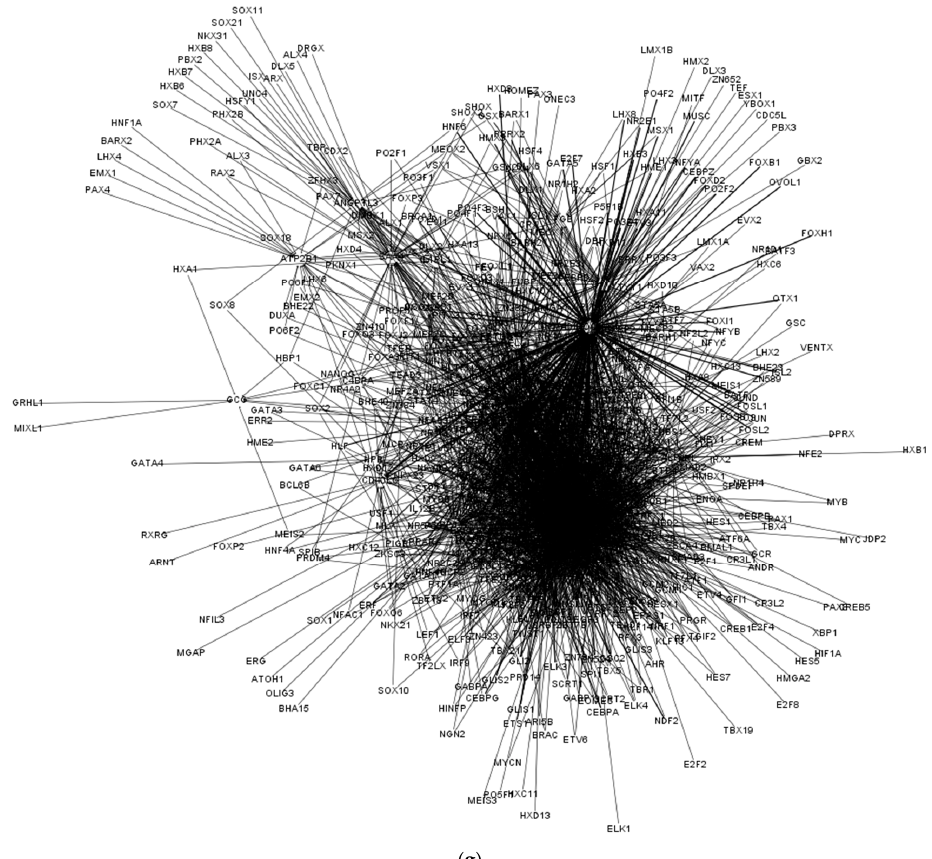
Figure 2. Receptor regulatory subnetworks of normal immune cells. In the network, nodes represent genes and transcription factors (TFs), while links represent gene regulatory relations. Arrows represent TFs regulating genes. The receptor regulatory subnetworks of: ( a ) B cell; ( b ) CD4 cell; ( c ) CD8 cell; ( d ) DC cell; ( e ) regulatory T cell; ( f ) T-helper1 cell; and ( g ) T-helper17 cell. Subnetworks have not been constructed for the immune cell subsets that do not have specific cell receptors.